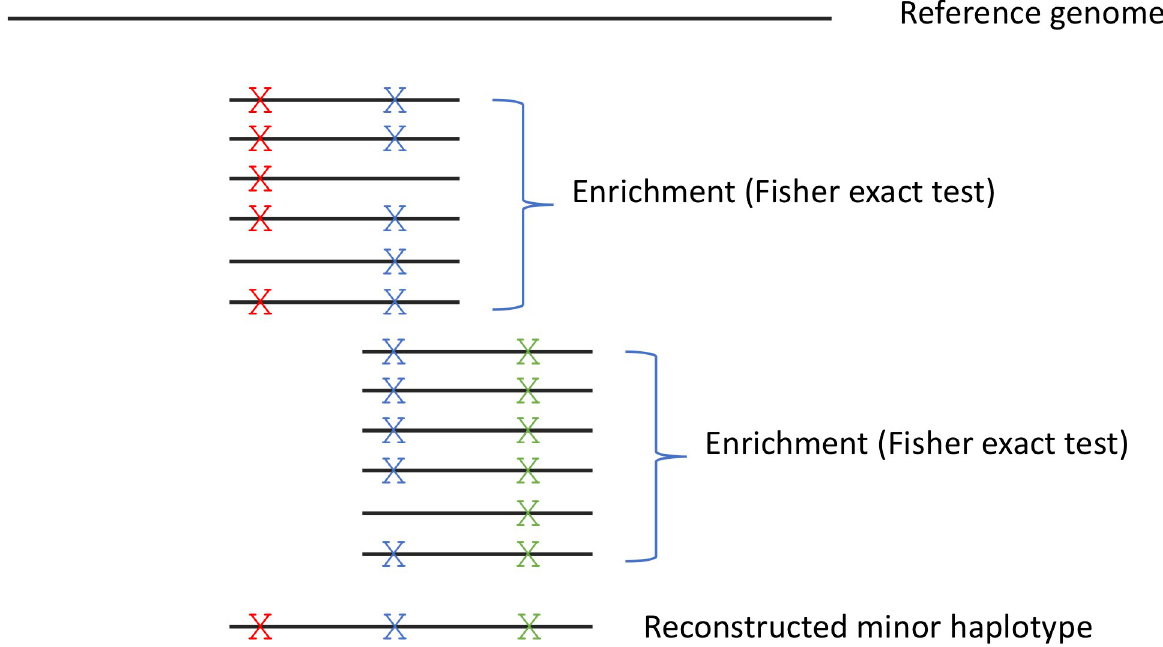
Fig 3. Illustration of method for haplotype reconstruction. The method searches for enrichment of pairs of mutations on the same read, and concatenation of enriched reads that share a mutation into a reconstructed minor haplotype. Notably, the concatenation approach is suitable for populations with limited diversity, as is the case in acute infections; in highly diverse populations, many haplotypes may share the “blue” mutation illustrated in the figure.